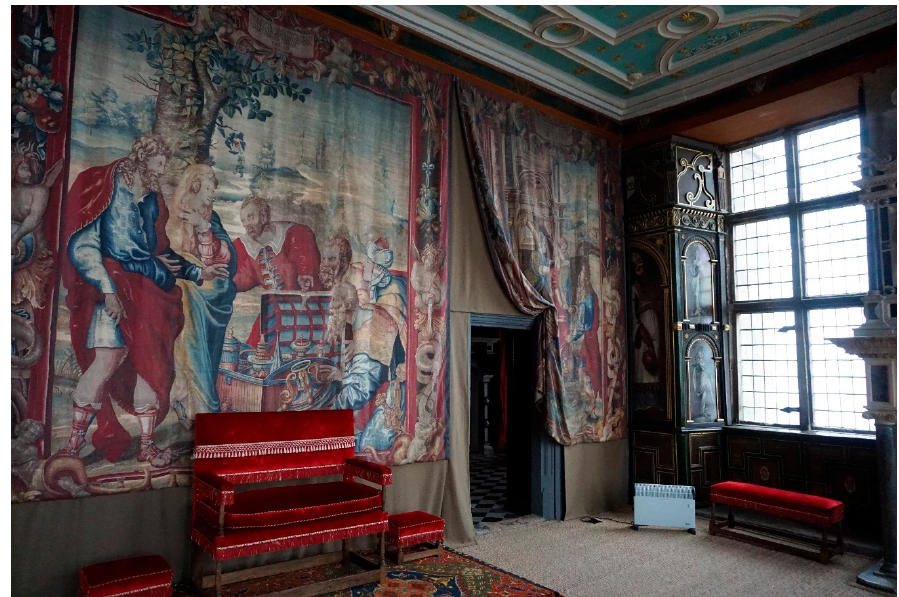
Figure 2. Bolsover Little Castle in Derbyshire, England, which dates from the beginning of